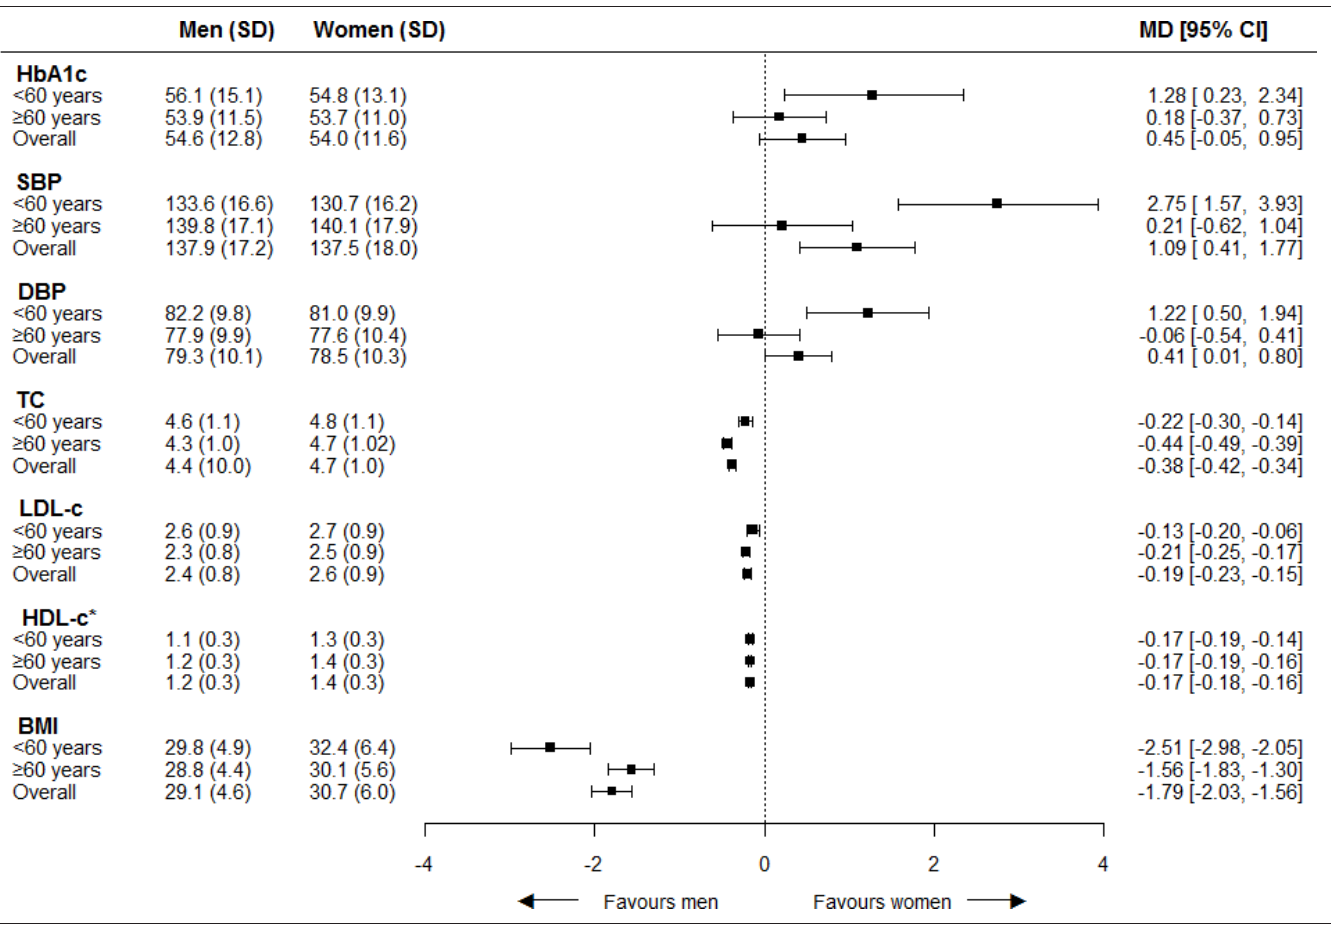
Figure 2 Women-to-men differences in cardiovascular risk factor levels. The analyses are adjusted for age. Women = reference category. BMI = body mass index. CI = confidence intervals. DBP = diastolic blood pressure. HDL-c = high-density liproprotein cholesterol. LDL-c = low-density liproprotein cholesterol. MD = mean difference. SBP = systolic blood pressure. SD = standard deviation. TC = total cholesterol. * Increased HDL-c is in favor of women. Mean (SD) for men and women separately not adjusted for